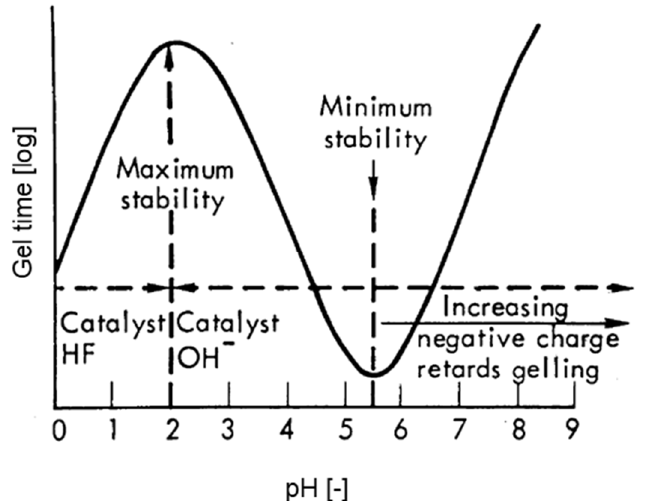
Figure 3. Dependence of gel time on pH in the absence of salts for Si sol stability, reprinted with permission from Ref. [1].